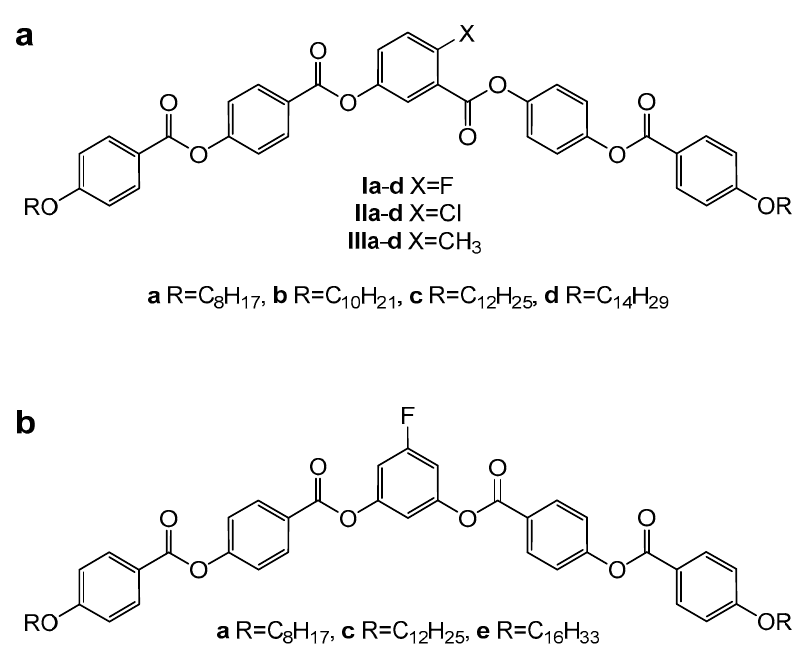
Figure 9. The structure of (a) materials based on 6-substituted 3-hydroxybenzoic acid studied in reference [34], and (b) materials derived from 5-substituted resorcinol studied in reference [29] .